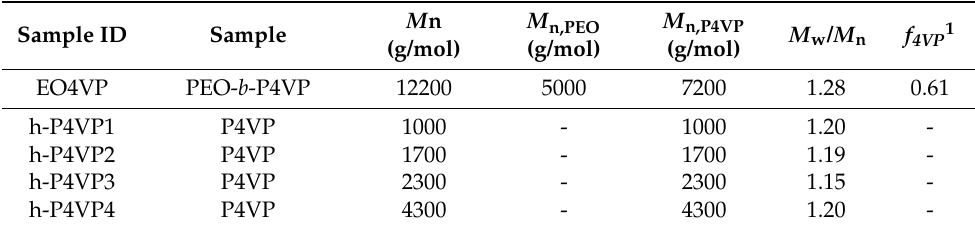
Table 1. The molecular characteristics of the copolymer and homopolymer samples used in this